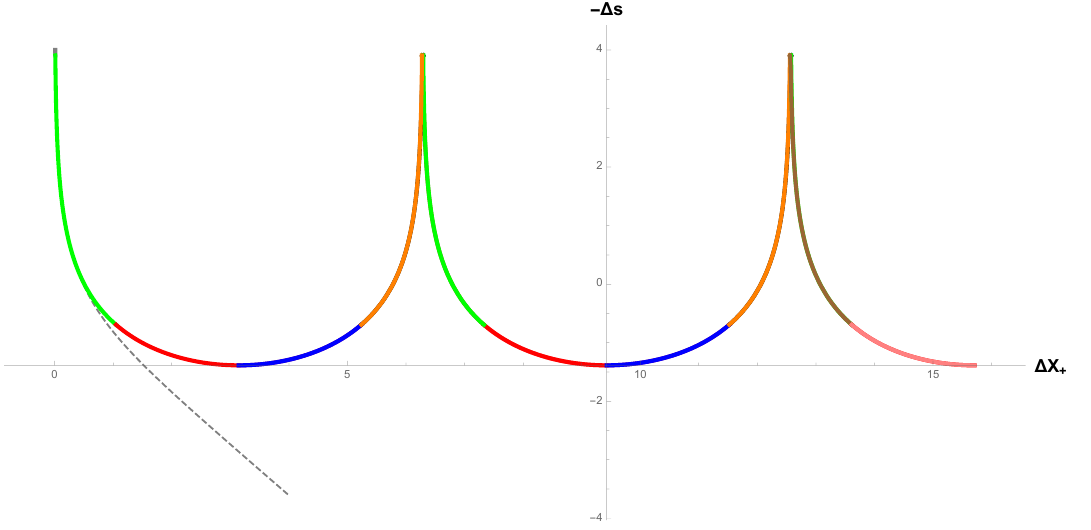
Figure 9 . All branches of geodesic length as function of (cid:1) X + for M = 1 and u (cid:3) = 100. Here the geodesic length behaves almost exactly like in the pure AdS 3